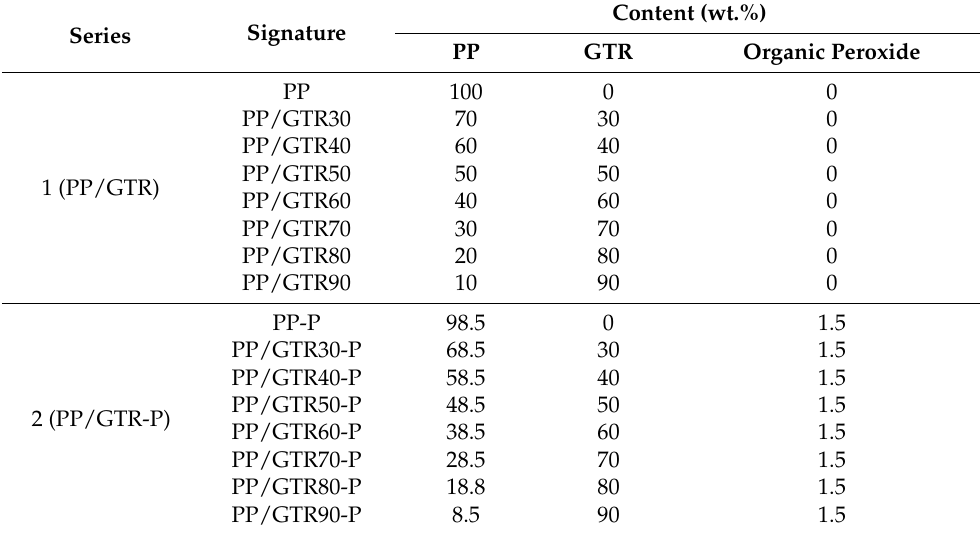
Table 1. List of prepared PP/GTR